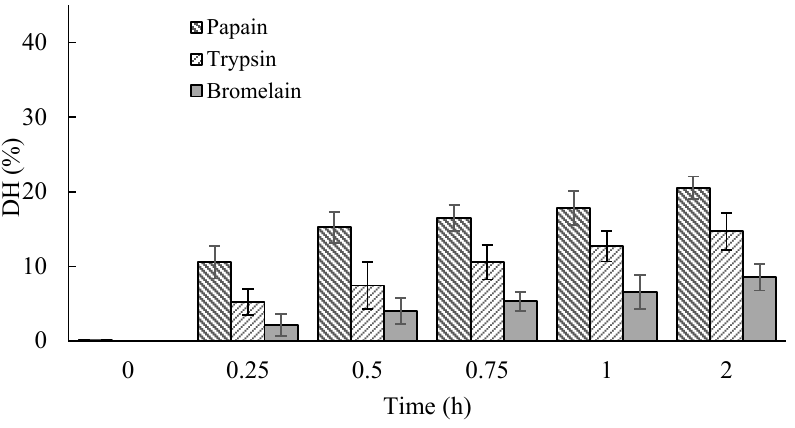
Figure 2. Hydrolysis of b-LG by papain, trypsin, and bromelain under 0.1 MPa at 40 °C.